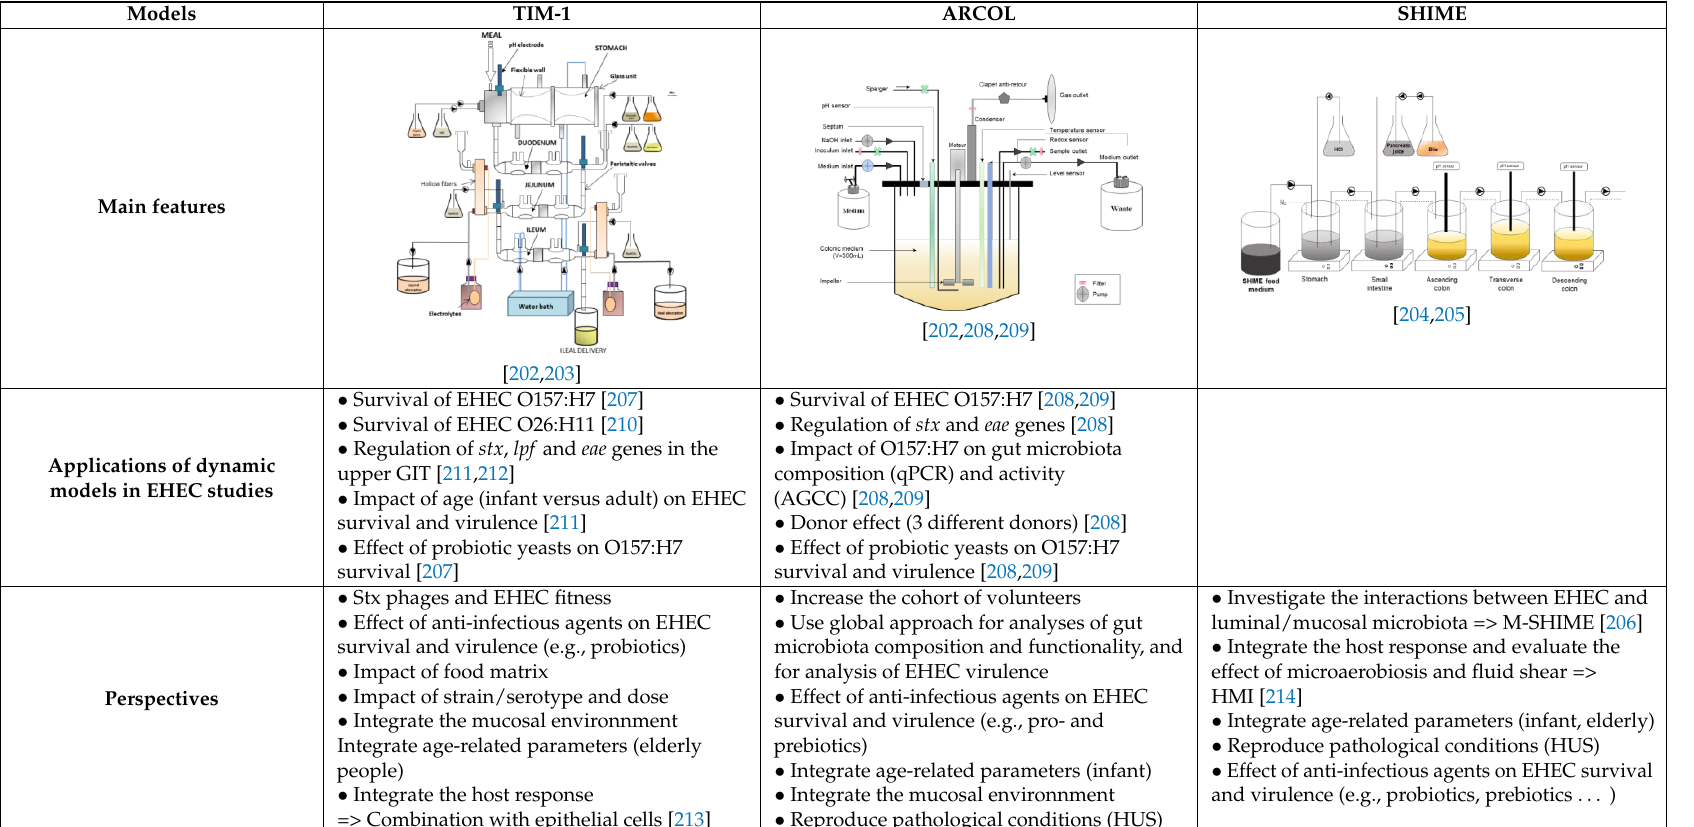
Table 1. Description of the main dynamic in vitro models of the human gut used to address EHEC physiopathology.